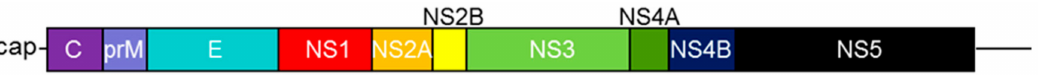
Figure 1. Genome organization. Schematic representation of the WNV (West Nile virus) genome. See text for